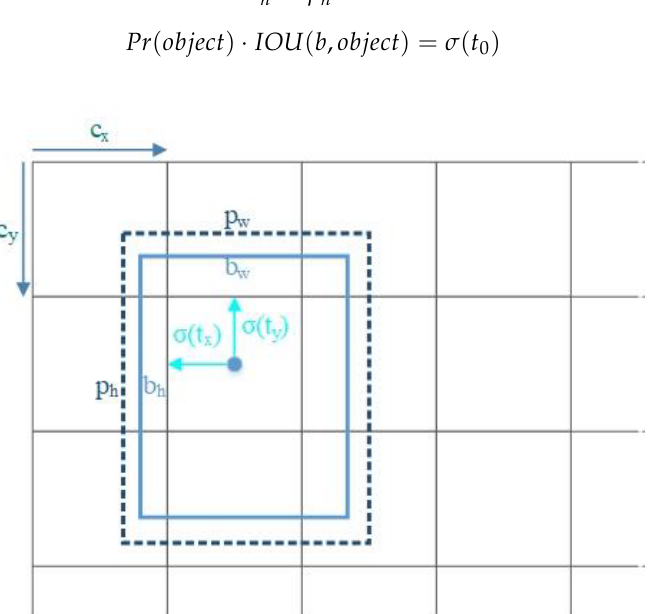
Figure 6. Bounding boxes and location